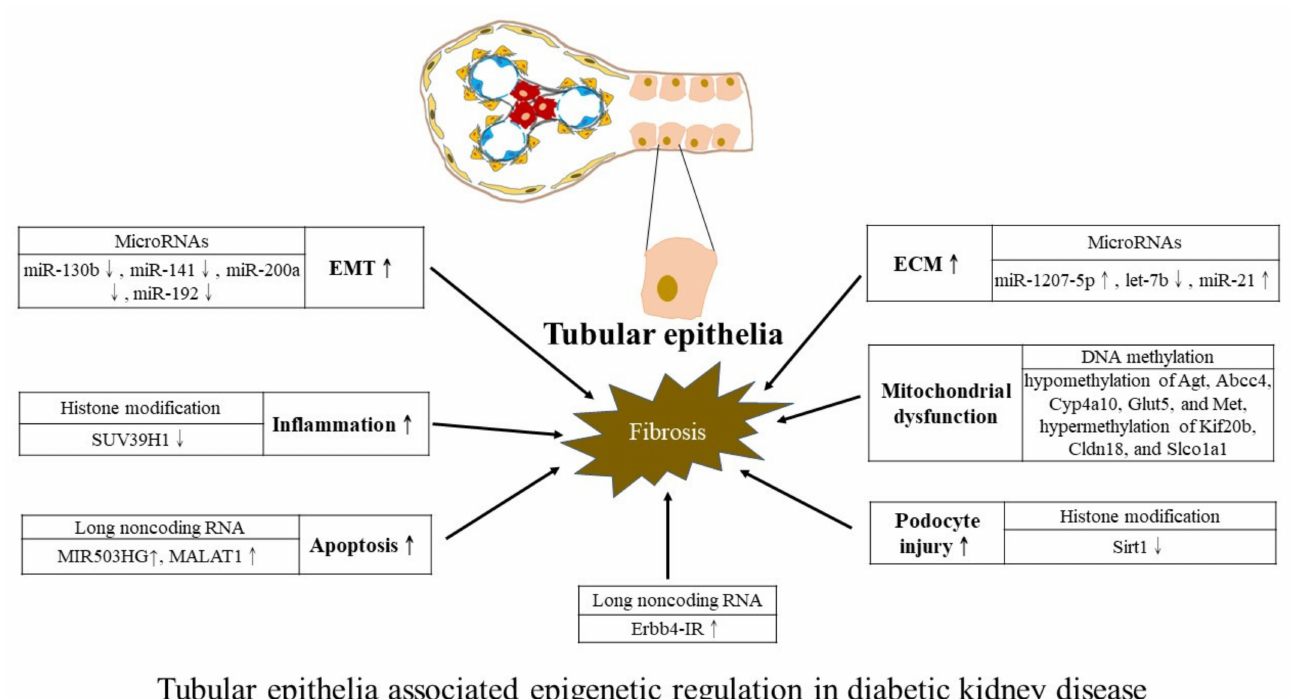
Figure 3. Podocyte-associated epigenetic regulation in DKD. Denote: ECM: Extracellular matrix and ER: Endoplasmic reticulum. Symbols: ↑ refers to increase; ↓ refers to decrease.